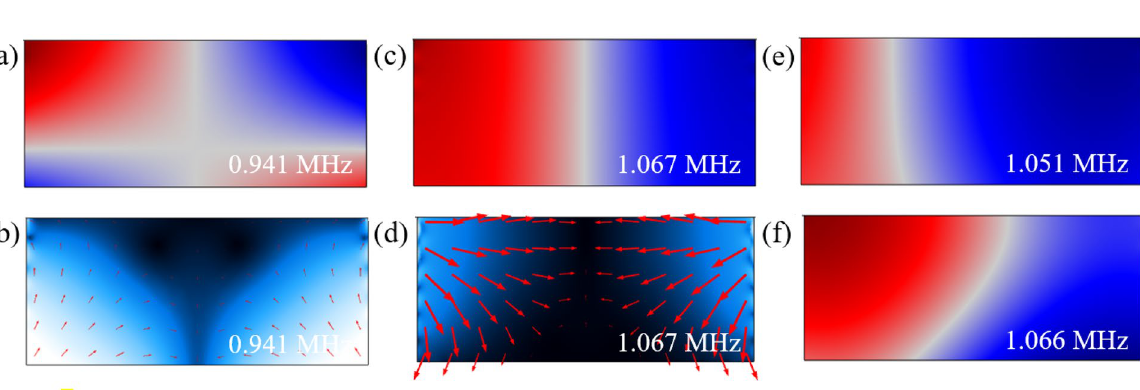
Figure 4. Numerical simulation of two-displacement and one-displacement actuations in the PDMS microchannel. ( a ) Surface plot of acoustic pressure (red (− 350 Pa) to blue (350 Pa)) and ( b ) surface and vector plot of the acoustic radiation force (from black (0 pN) to white (0.001 pN)) for the resonance frequency of 0.941 MHz under the two-displacement actuation. ( c ) Surface plot of acoustic pressure (blue (− 3.2 kPa) to red (3.2 Pa)) and ( d ) surface and vector plot of the acoustic radiation force (black (0 pN) to white (3.5 pN)) for the resonance frequency of 1.067 MHz under the two-displacement actuation. ( e ) and ( f ) surface plot of acoustic pressure, respectively, for the resonance frequency of 1.051 MHz (blue (− 2.9 kPa) to red (2.9 kPa)) and 1.066 MHz (blue (− 1.5 kPa) to red (5.2 kPa)) under the one-displacement